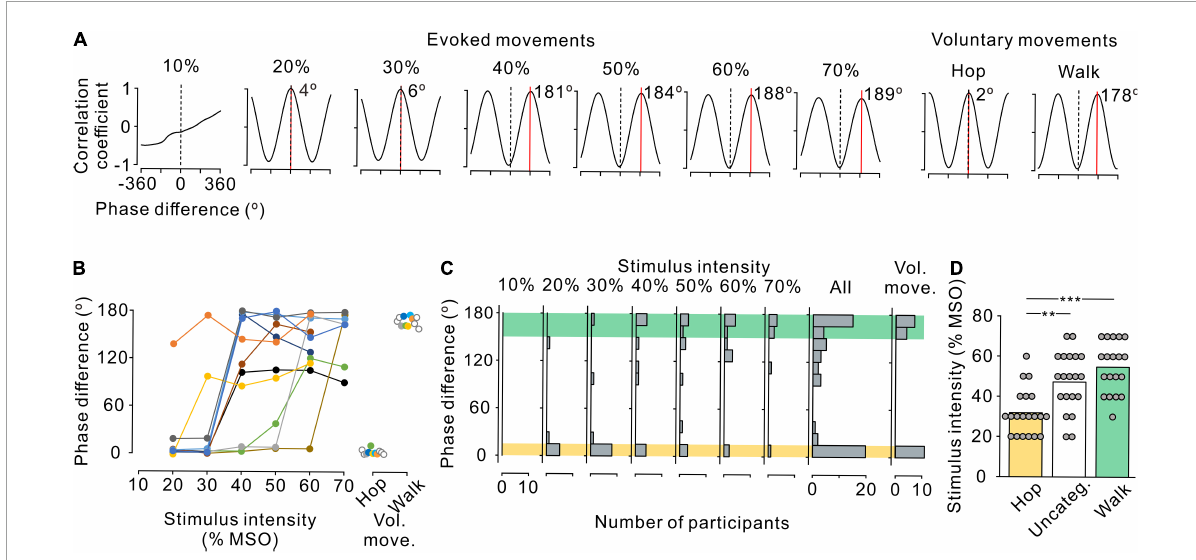
FIGURE3 Phase difference between left and right leg movements. (A) Cross-correlograms of left and right leg movements at the anterior-posterior axis in a single participant during stimulus-evoked movements (left seven panels) and voluntary movements (right two panels). Phase difference between the left and right step cycles was estimated by the time shift of the peak coefficient of correlation multiplied by the fundamental angular frequency. Red line and inset number in each correlogram indicate the phase shift on the positive peak. Note that a positive (right) shift indicates the leading of left movements with reference to right movements. (B) Phase difference between left and right leg movements during stimulus-evoked movements at different stimulus intensities (left) and voluntary movements (right) in all participants. Colored symbols and lines represent data for each individual participant. Open circles represent the participants in whom only voluntary movements were measured (right panel). Note that the absolute values of phase differences were transformed to a range of 0–180 ◦ . (C) Histograms of the number of participants with leg movements at different left-right phases. From left to right, the stimulus-evoked leg movements at 10–70% maximum stimulator output (MSO) and all intensities combined and voluntary leg movements. Yellow and green hatched areas indicate the range of phase difference obtained during the voluntary hopping (0–15 ◦ ) and walking (150–180 ◦ ) movements, respectively. (D) Stimulus intensity during the three patterns of stimulus-evoked leg movements defined based on the range of voluntary hopping and walking movements: hopping-like (hop, 0–15 ◦ , yellow), uncategorized (Uncateg., 15–150 ◦ , white), and walking-like (walk, 150–180 ◦ , green). Gray circles represent individual participants at all stimulus conditions. Significant differences were revealed by post hoc multiple comparisons following analysis of variance (** p < 0.01 and *** p <